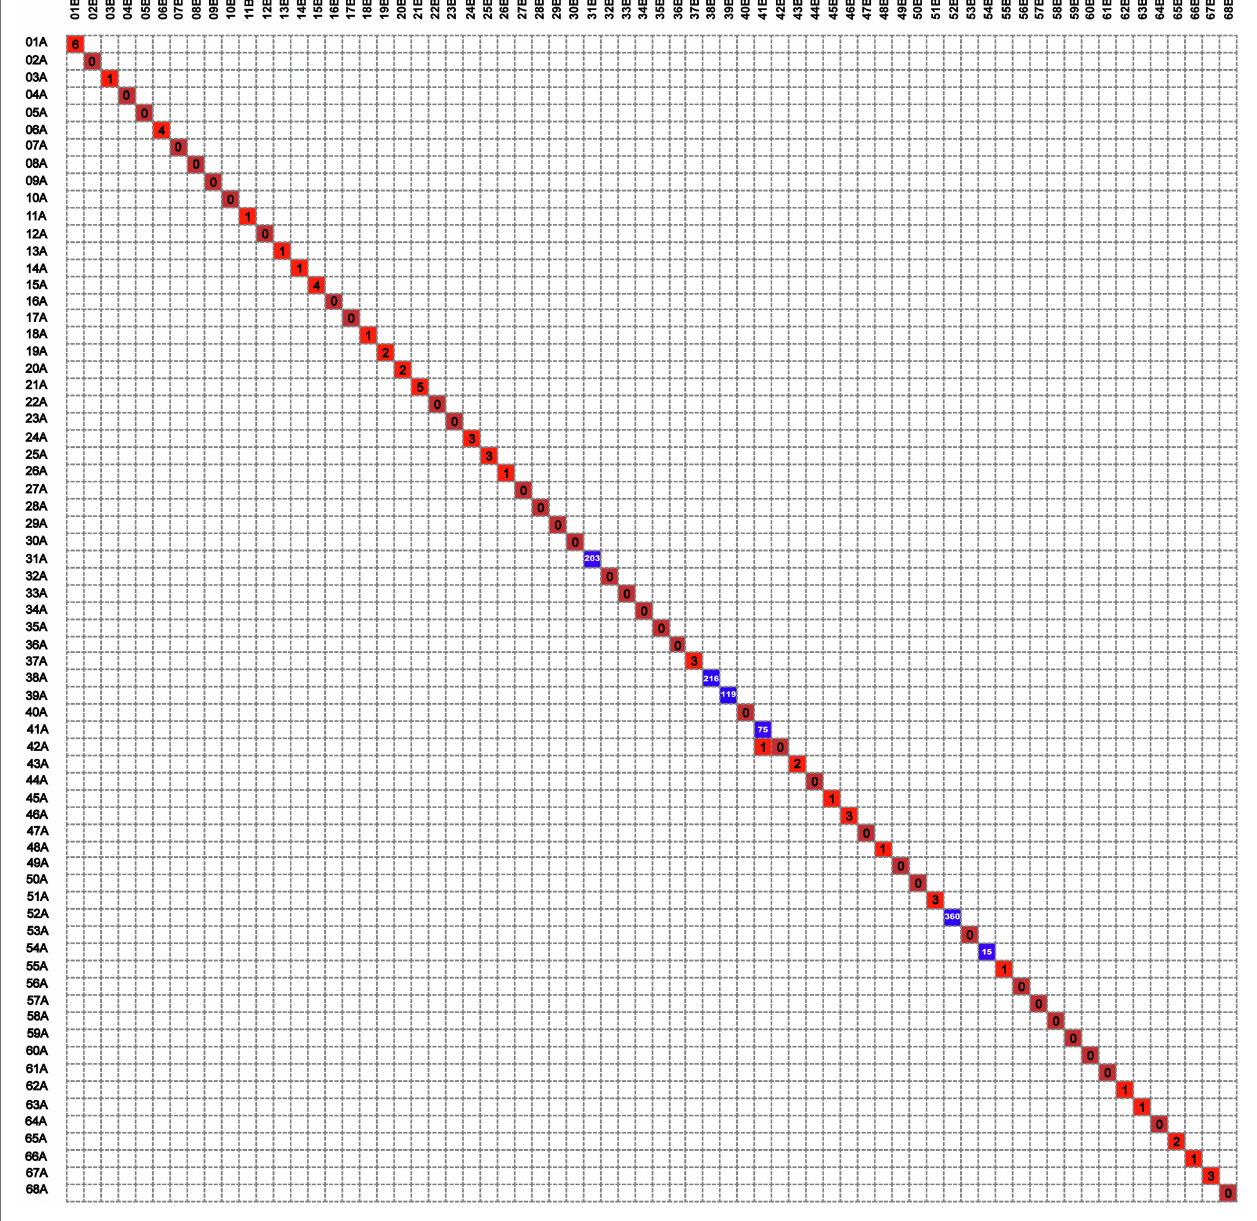
FIGURE 2 | The digital matrix chart of the differential single-nucleotide polymorphisms (SNPs) of 68 patients with TB